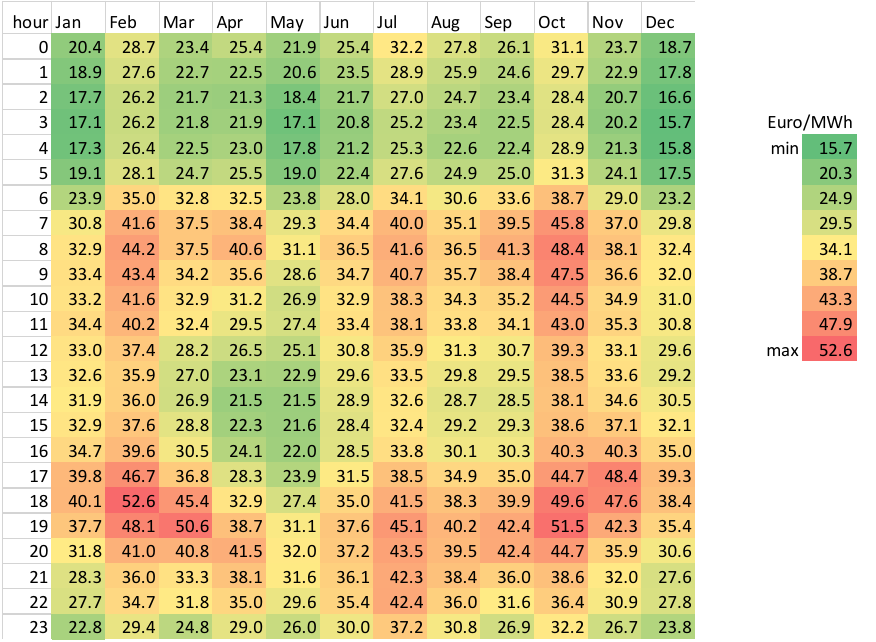
Figure 2. Monthly mean values of spot market prices for each hour of the day based on 15 min values per year (green/red color: low/high spot market prices).